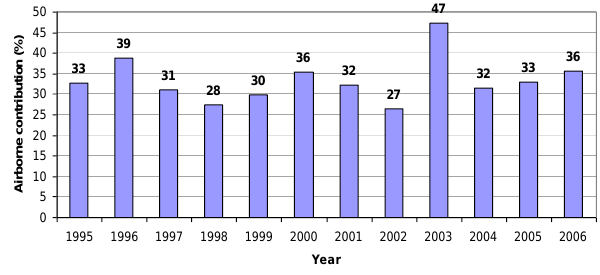
Fig. 1. Annual airborne contribution to total (waterborne plus air- Fig. 1 . Annual airborne contribution to total (waterborne plus airborne) input of nitrogen into borne) input of nitrogen into the Baltic Sea basin in the period the Baltic Sea basin in the period 1995-2006. Units. % of total input. 1995–2006. Units: % of total input.